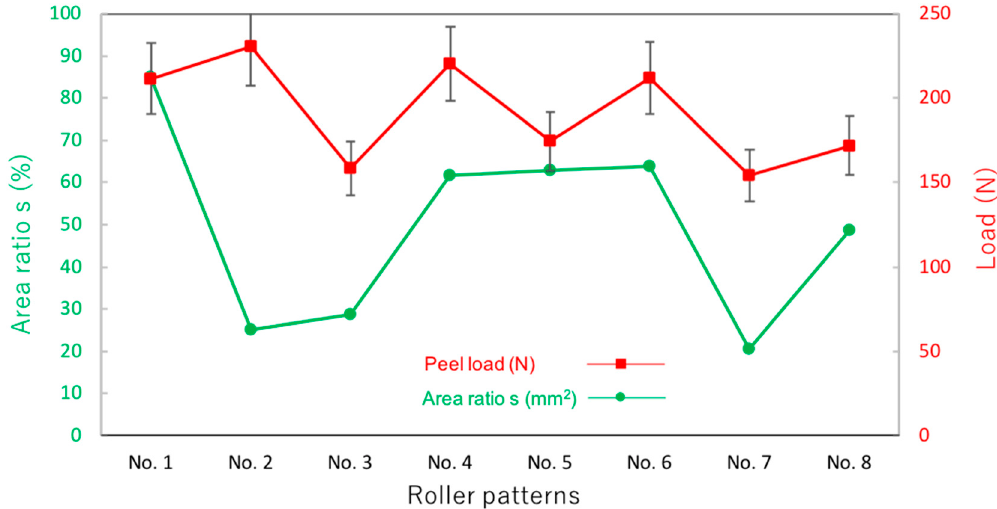
Figure 11. Relationship between the load and the area ratio with different patterns.